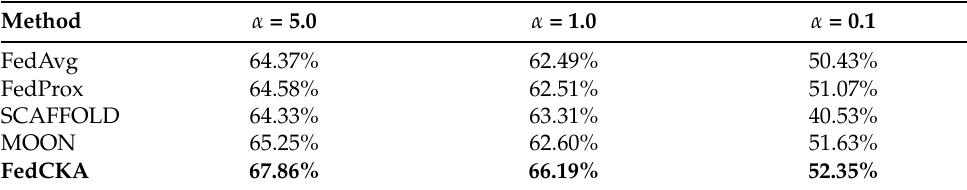
Table 2. Accuracy across α ∈ [ 5.0,1.0,0.1 ]